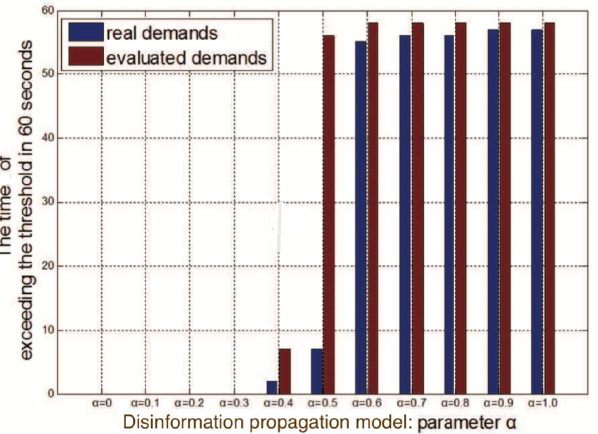
Figure 14. Attack effects of real changing demands and evaluated changing demands with the change of parameter α .